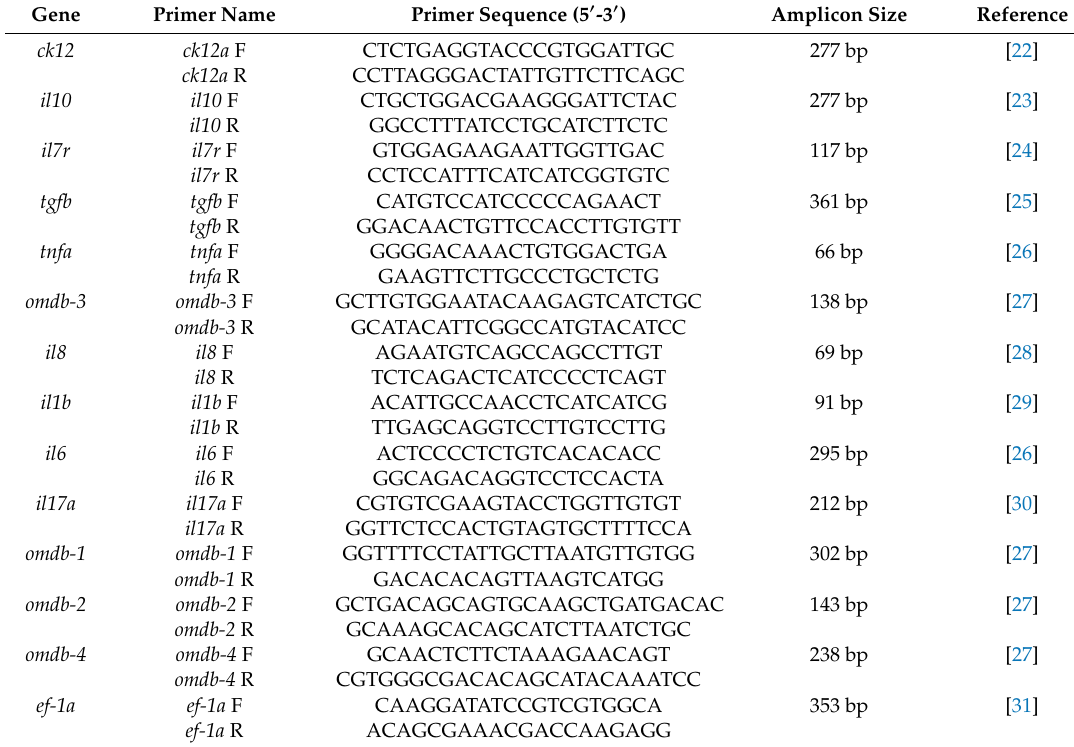
Table 1. Primers used in this